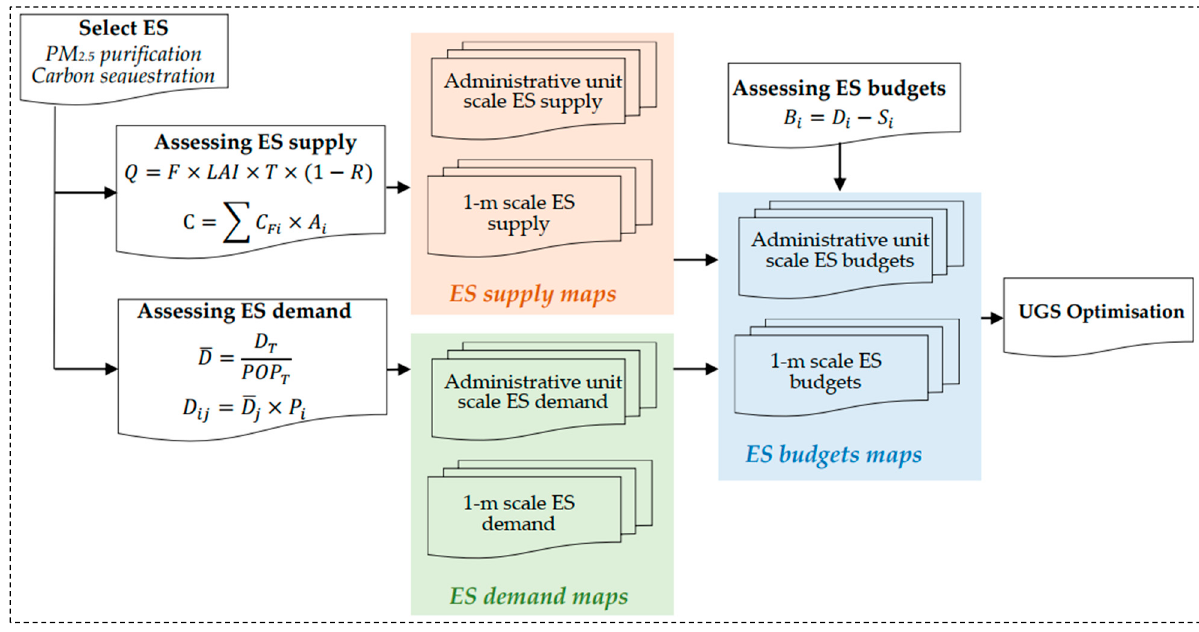
Figure 4. Conceptual framework of methodology.